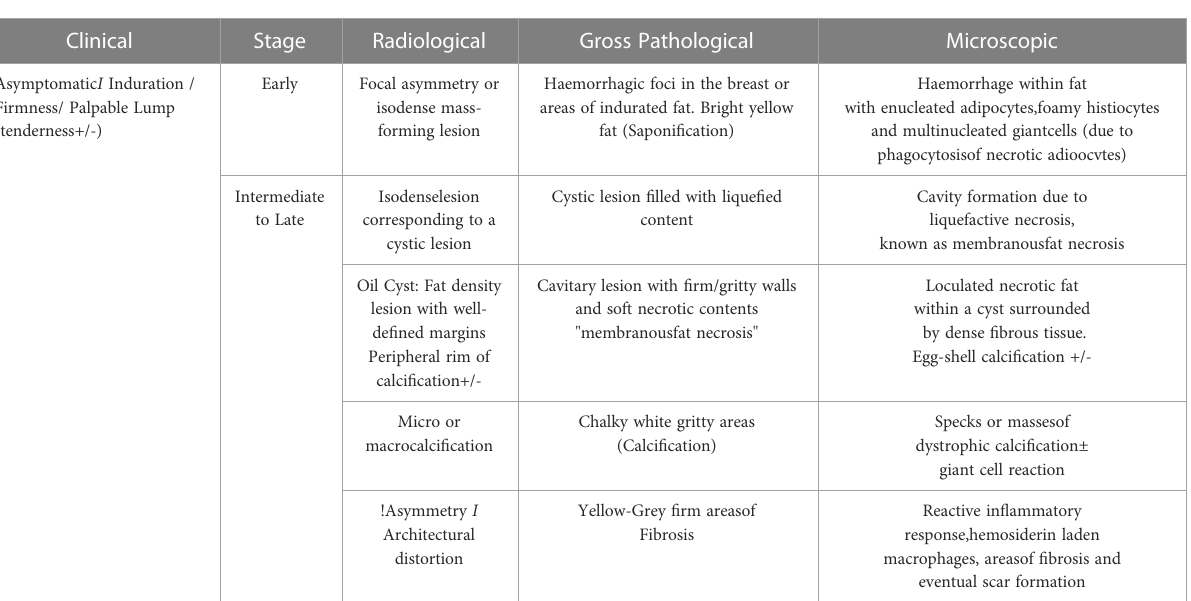
TABLE 1 Clinical-Radiological-Pathological correlation with underlying pathology in Fat